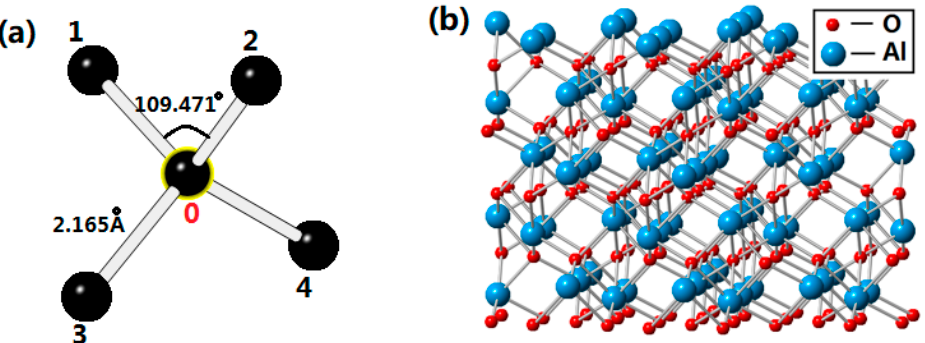
Figure 3. ( a ) The smallest structural unit of silicon; ( b ) atomic structure of